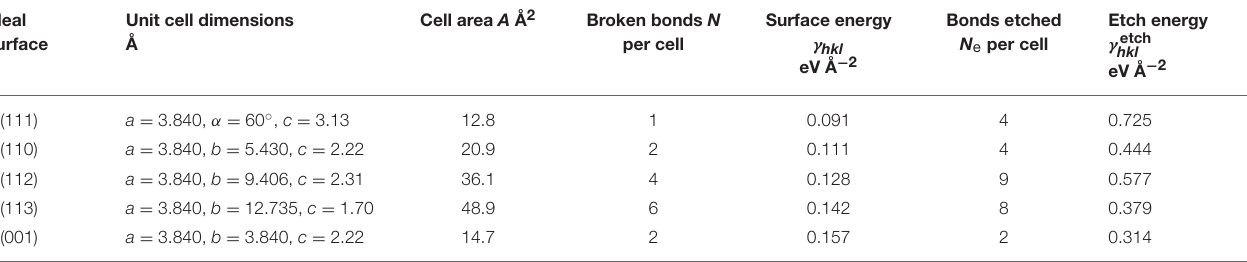
TABLE 1 | The parameters required for the calculation of the surface energy γ hkl and etch energy γ etch hkl are collected for the five most commonly encountered planes of Si in MACE. Ideal